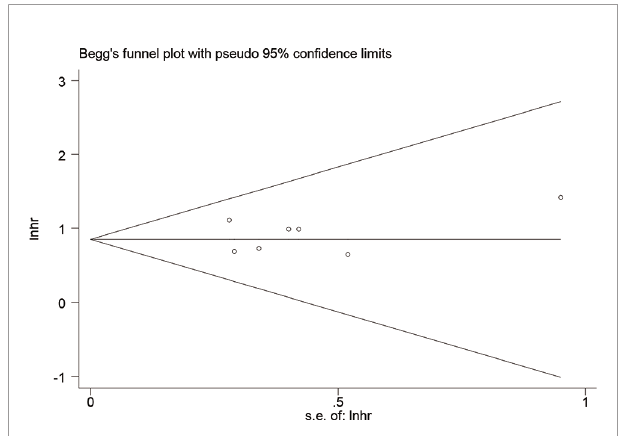
FIGURE 3 | Forest plot overall survival of all patients and subgroup